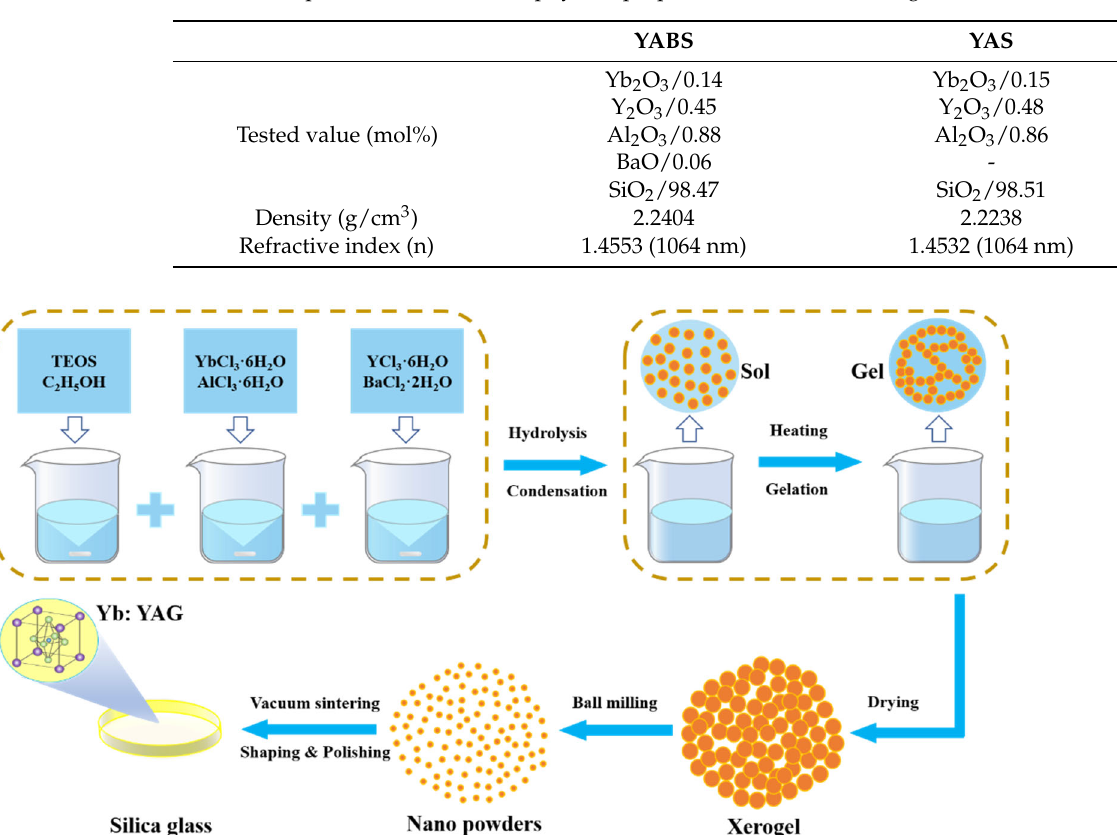
Table 1. Component test values and physical properties of YABS and YAS glass.